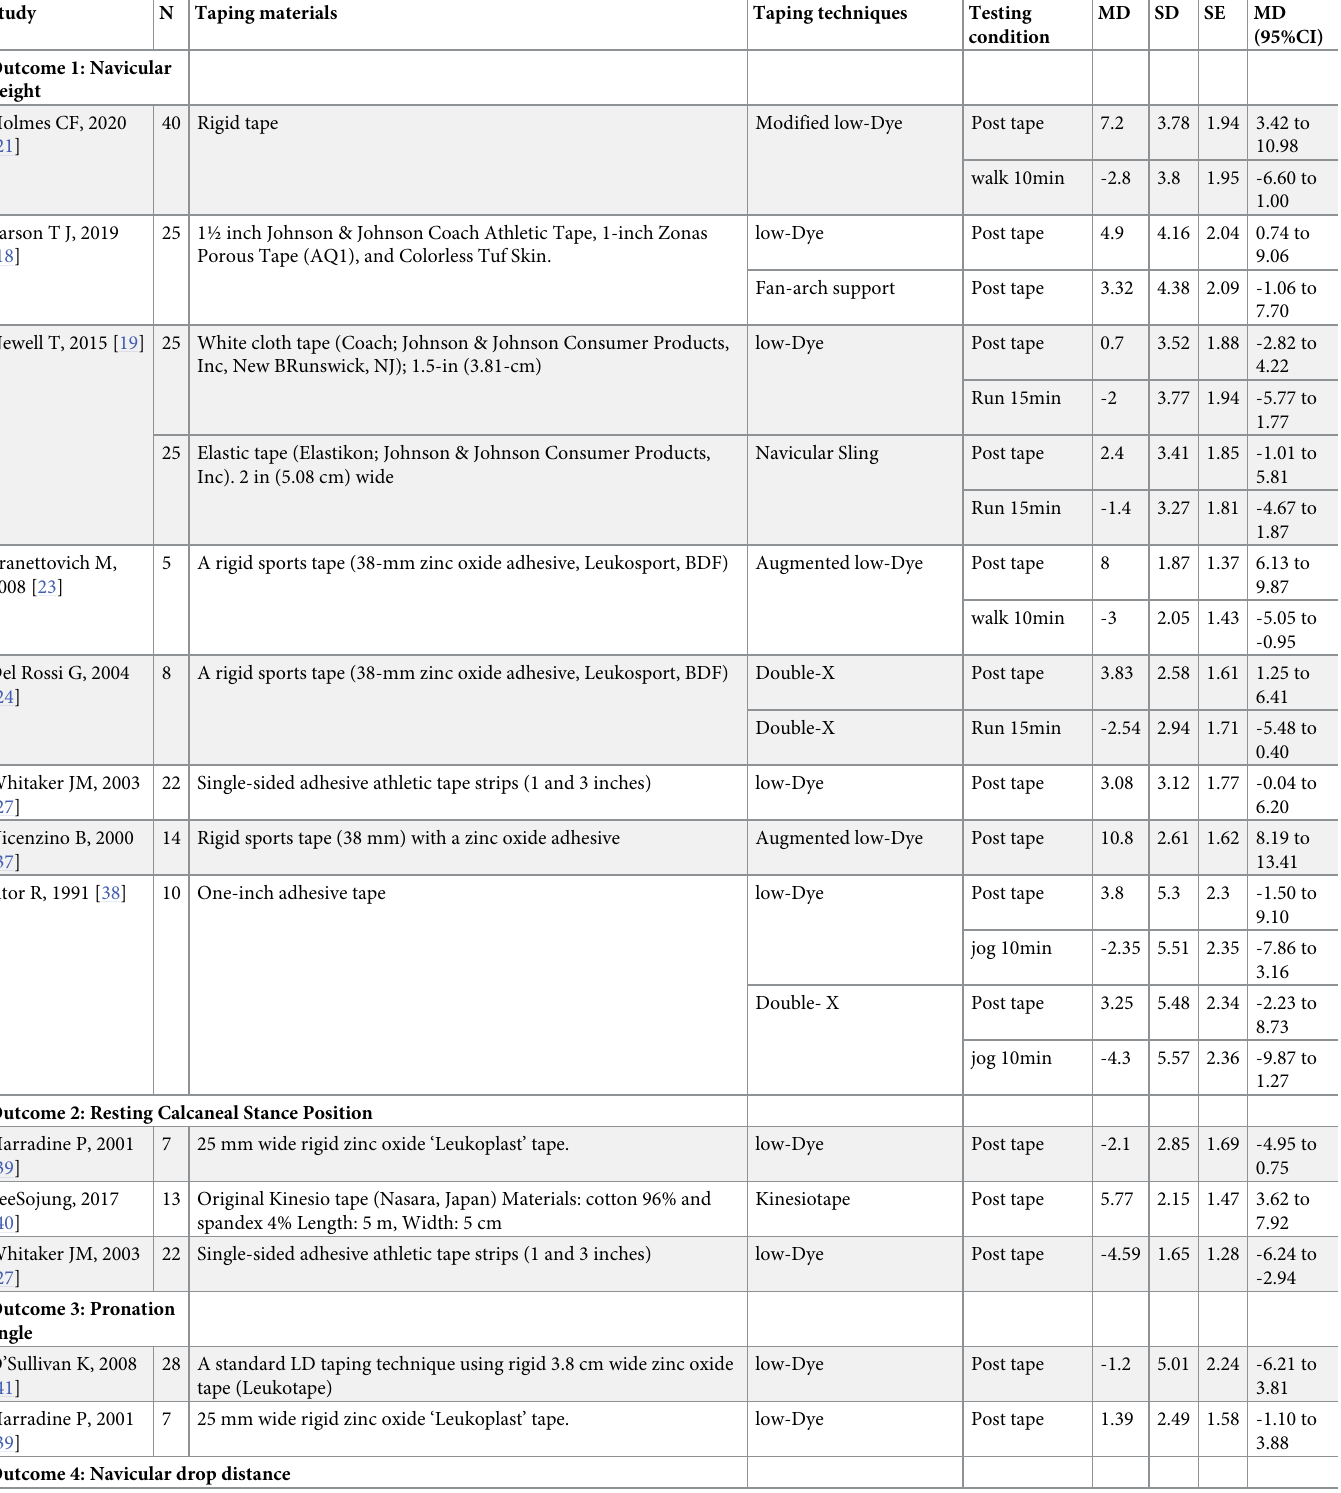
Table 1. The summary of included studies examining the efficacy of kinesio tape.